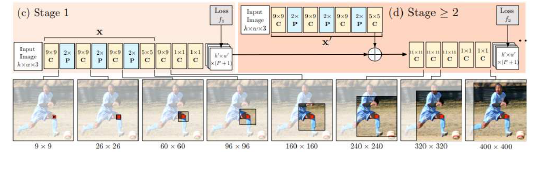
Fig. 4: Illustration of the detail model to extract the feature for training model and to predict the heatmaps at each stage